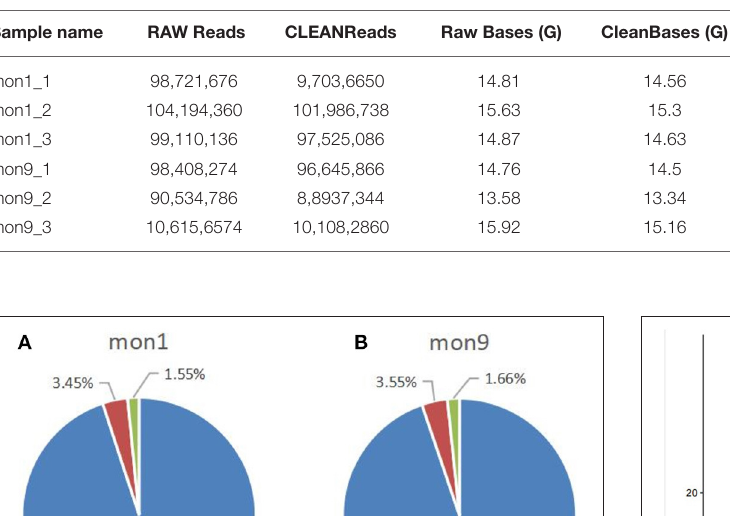
TABLE 2 | Read quality for RNA-seq.